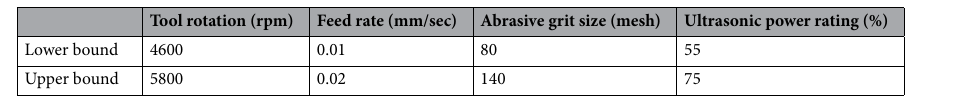
Table 7. Lower and upper bound of RUM